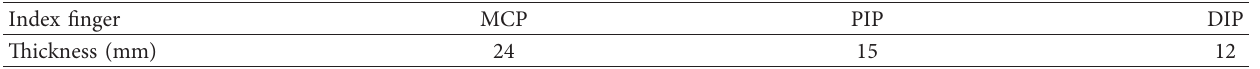
Table 3: Thickness of the knuckles of a 21-year-old woman (index finger).